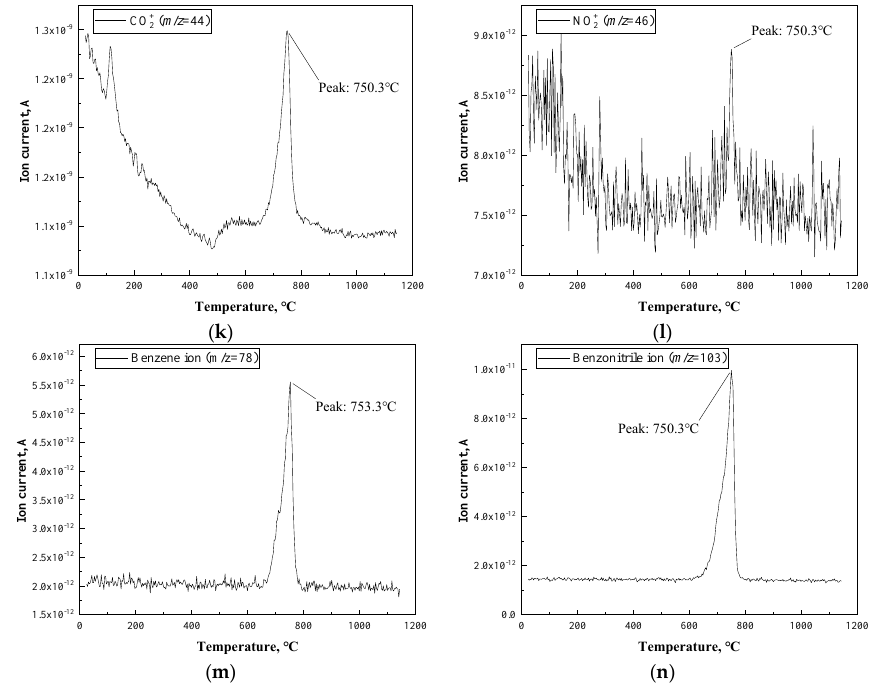
Figure 2. Thermalgravimetric analysis coupled with mass spectroscopy (TGA-MS) results of PBO fiber heated up to 1150 °C under an inert argon atmosphere. ( a ) H + 2 H 2 O + ; ( f ) C 2 H + ; ( g ) HCN + ; ( h ) CO + or N + ion. 2